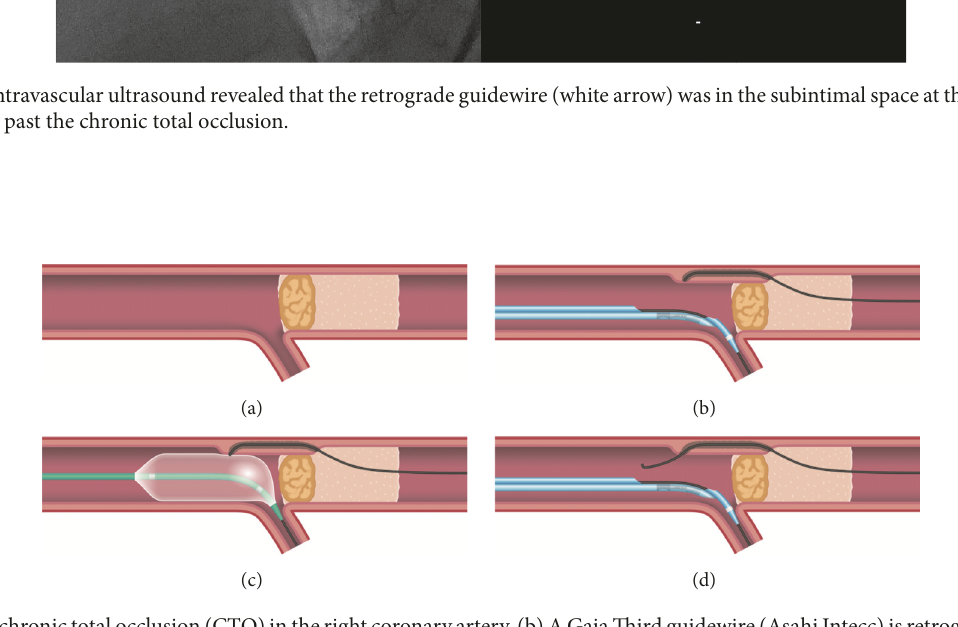
Figure 4: (a) A chronic total occlusion (CTO) in the right coronary artery. (b) A Gaia Third guidewire (Asahi Intecc) is retrogradely advanced intothesubintimalspacepasttheCTOostium.(c)Anantegradeballoon-assistedsubintimalreentryisperformed,whichiscreatedproximally to the occluded segment using a large balloon. (d) The retrograde guidewire successfully penetrated the proximal true